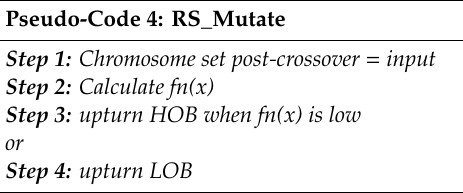
Table 7. Pseudo-code 4 for RS_Mutate